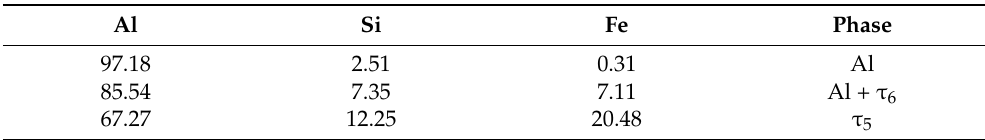
Table 2. Energy dispersive spectroscope (EDS) of AS60/60 coating in the hot-dipped condition (at.